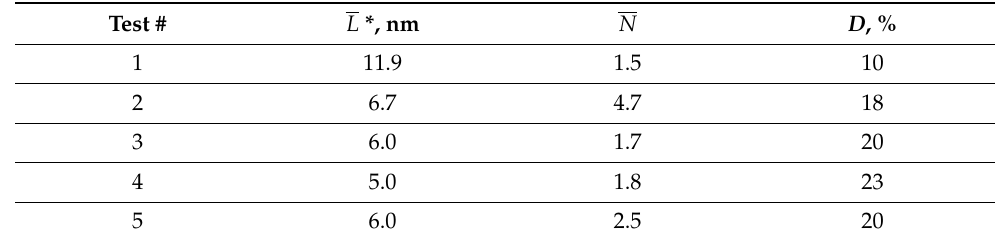
Table 6. Geometrical parameters of catalyst active phase (MoS 2 ) in polycondensation products from heavy oil hydroconversion